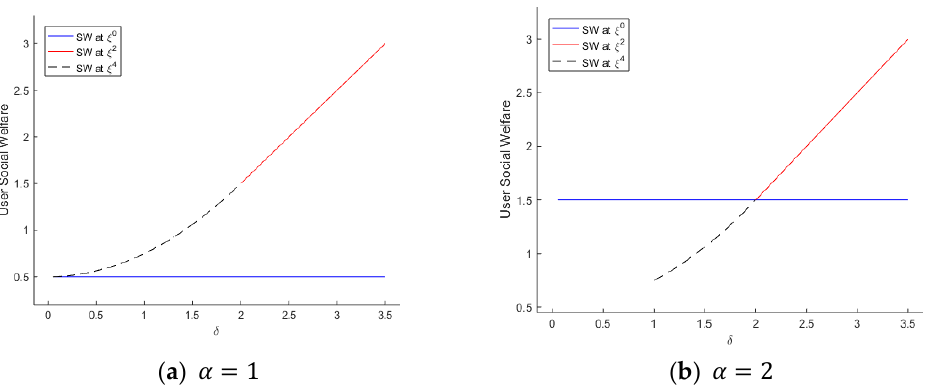
Figure 4. Users ’ SW changes as the backward compatibility ( 𝛿 ) varies. Figure 4. Users’ SW changes as the backward compatibility ( δ )